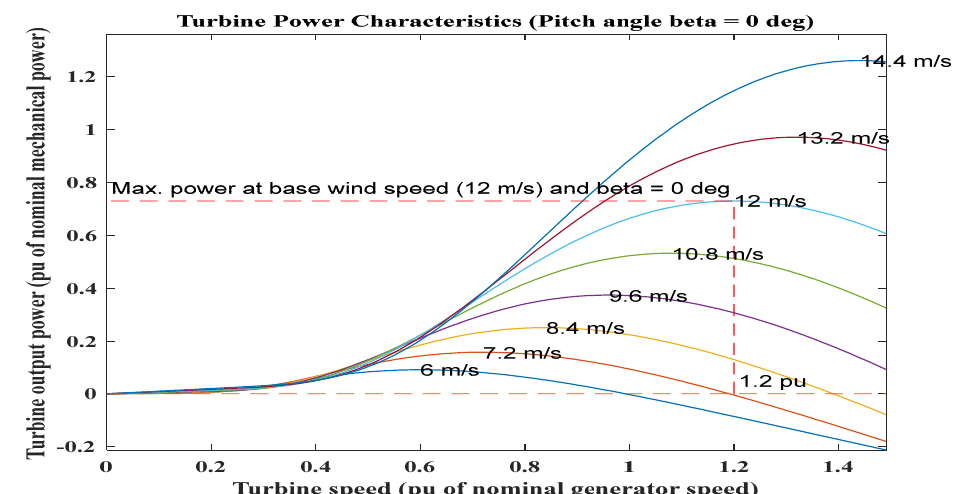
Figure 6. Graphical representation of mechanical power concerning turbine speed under fluctuating wind speed.